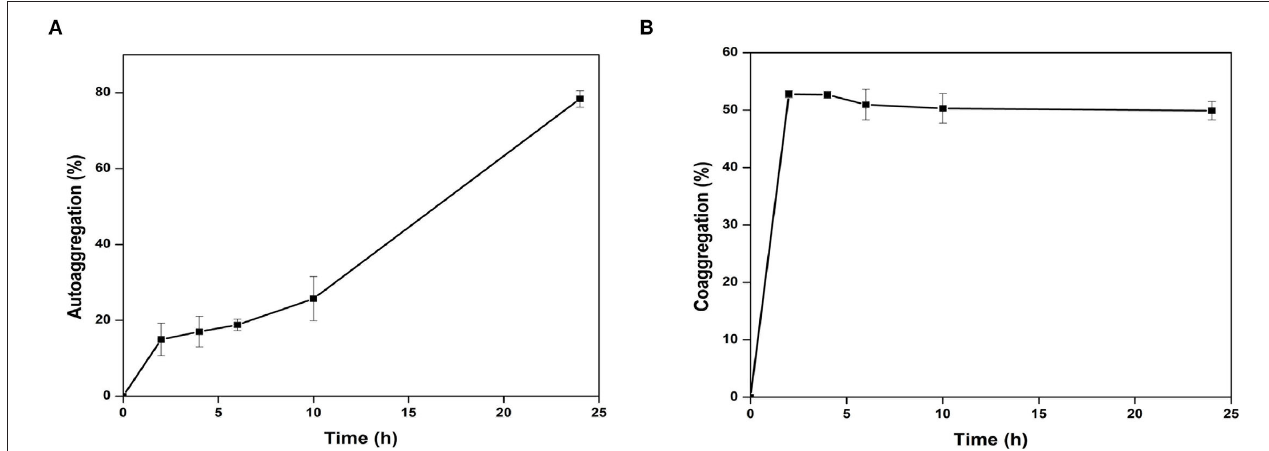
FIGURE 6 | Autoaggregation (A) and Co-AGGREGATION (B) of Cytobacillus oceanisediminis NB2 with pathogen mixture of E. coli, Staphylococcus aureus, and Salmonella typhimurium .